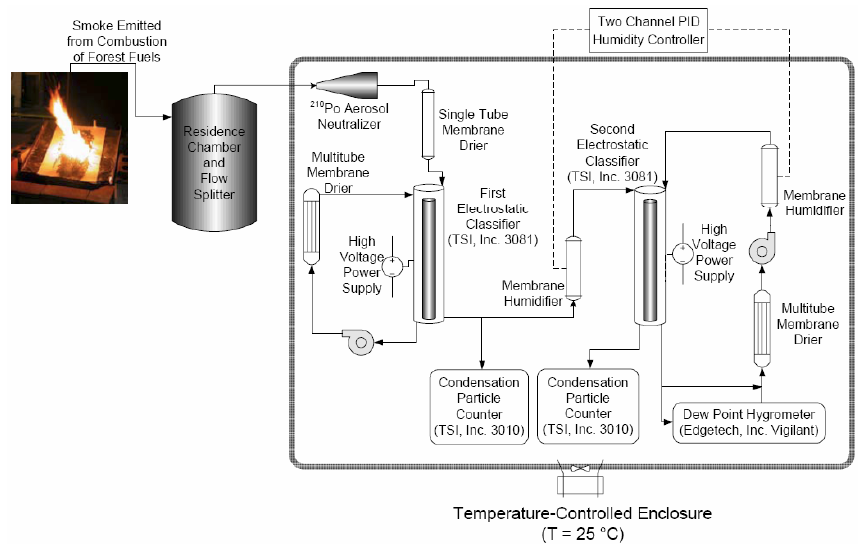
Fig. 1. Schematic of experimental apparatus for smoke aerosol hygroscopicity measurements.